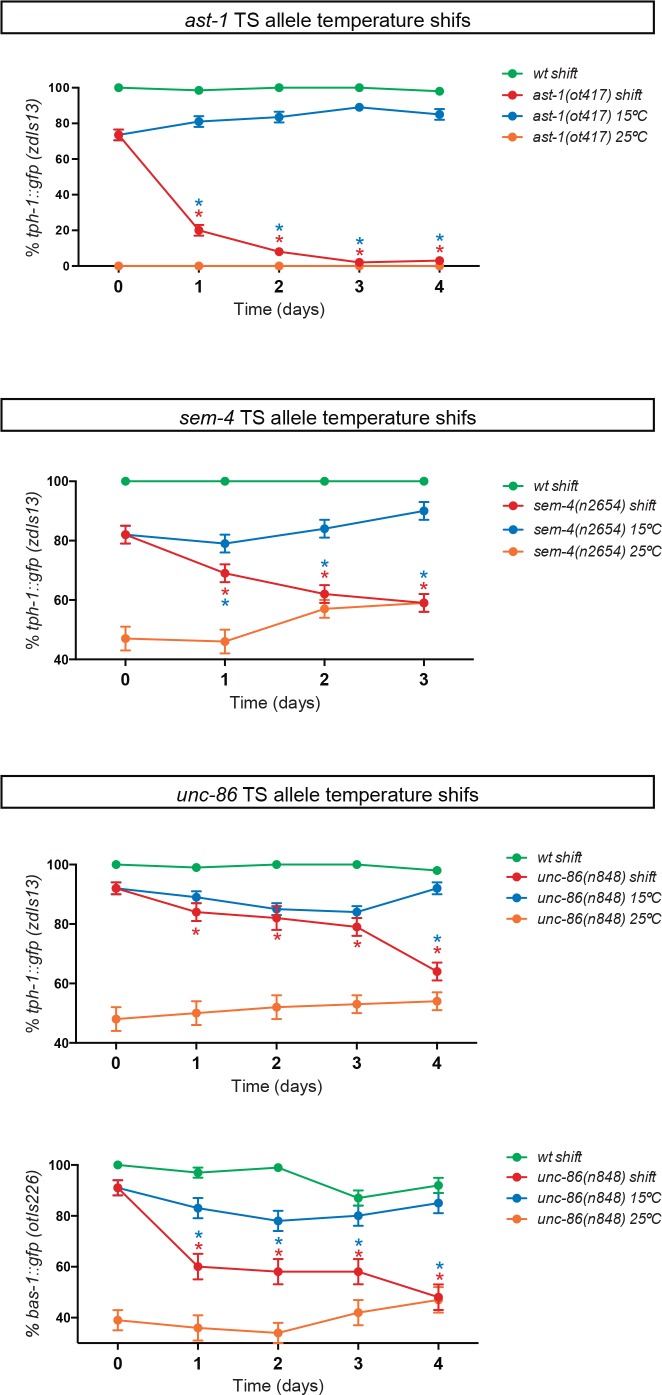
AST-1, UNC-86 and SEM-4 are required to maintain the HSN differentiated state.Three temperature-sensitive alleles ast-1(ot417), unc-86(n848) and sem-4(n2654) were used to perform temperature shifts to restrictive temperatures after HSN has fully differentiated (young adult). Temperature shifts (red lines) lead to reporter expression defects. Red asterisks refer to the comparison between mutant values before and after the temperature shift and blue asterisks refer to the comparison at the same time point between shifted animals (red line) and animals kept at permissive temperature (blue line) (n > 100 cells per condition). Fisher's exact test, *: p-value<0.05. Related to Figure 3.